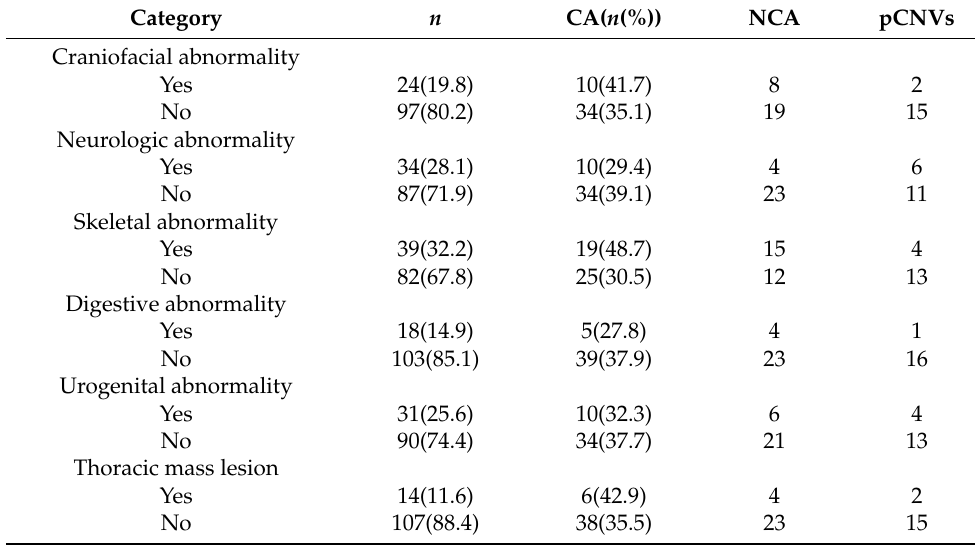
Table 2. Distribution of ECAs and the incidence of CA in 121 fetuses with